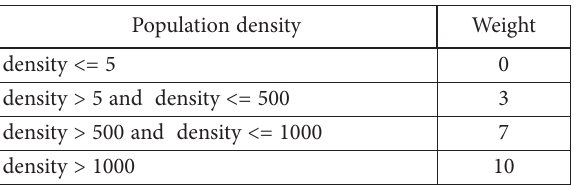
Table 1. Population density weights Population density